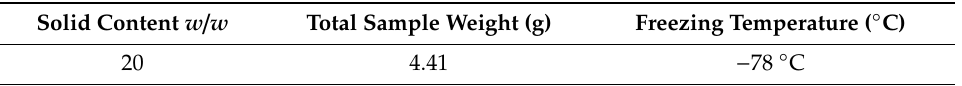
Table 1. Sample preparation